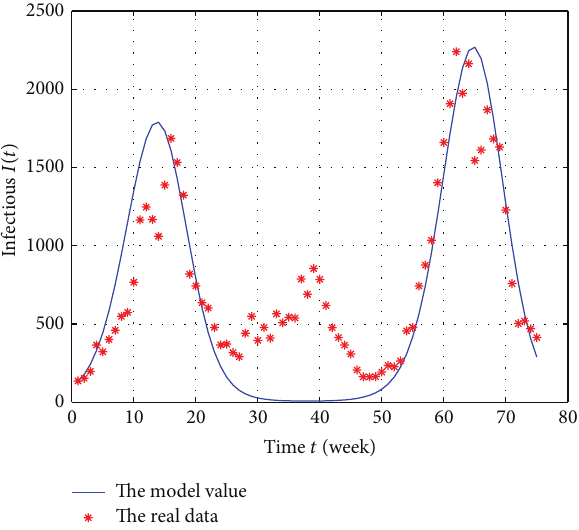
Figure 2: The solid curve represents the simulation results and the stars are the weekly data from 2011 to 2012 reported by the Wenzhou